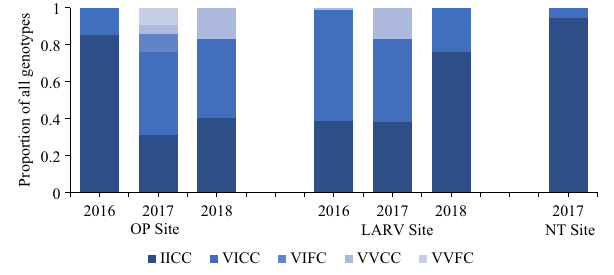
Fig. 2 Genotype distribution for V1016I and F1534C over time at 3 different field sites in Pasco County, FL. Darker colors indicate a more resistant genotype while lighter colors indicate a less resist- ant genotype. IICC = homozygous resistant for both 1016 and 1534 alleles; VICC = heterozygous for 1016 allele and homozygous resist- ant for 1534 allele; VIFC = heterozygous for both 1016 and 1534 allele; VVCC = homozygous susceptible for 1016 allele and homozy- gous resistant for 1534 allele; VVFC = homozygous susceptible for 1016 allele and heterozygous for 1534